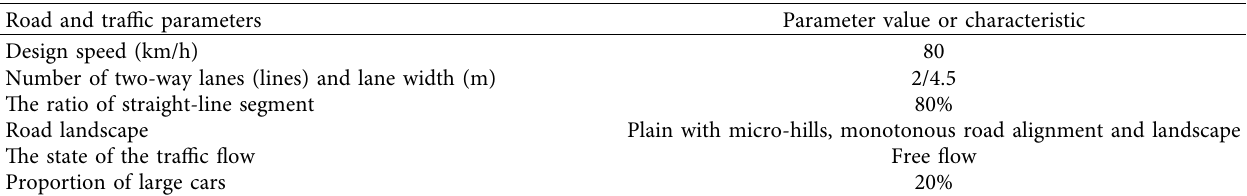
Figure 1: Main experimental equipment. (a) I view X HED helmet-mounted eye tracker. (b) MP150 physiological tester. (c) The test vehicle. (d) Eye movement data collection interface. (e) ECG data acquisition interface. Table 1: Road and traffic parameters of test road